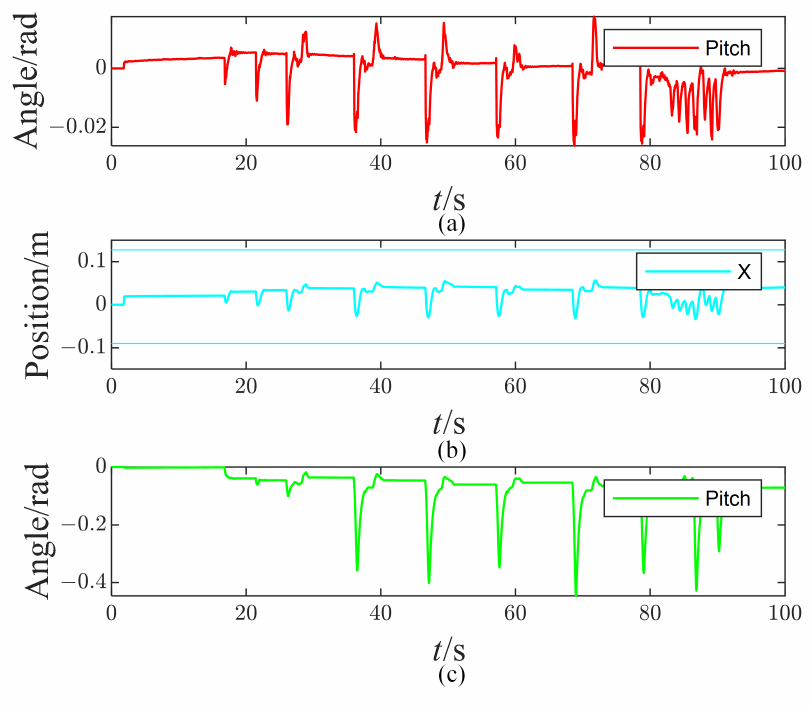
Figure 7. The measured pitch angle of the right foot ( a ), CoM position along the X axis ( b ), and the pitch angle of the torso ( c ).